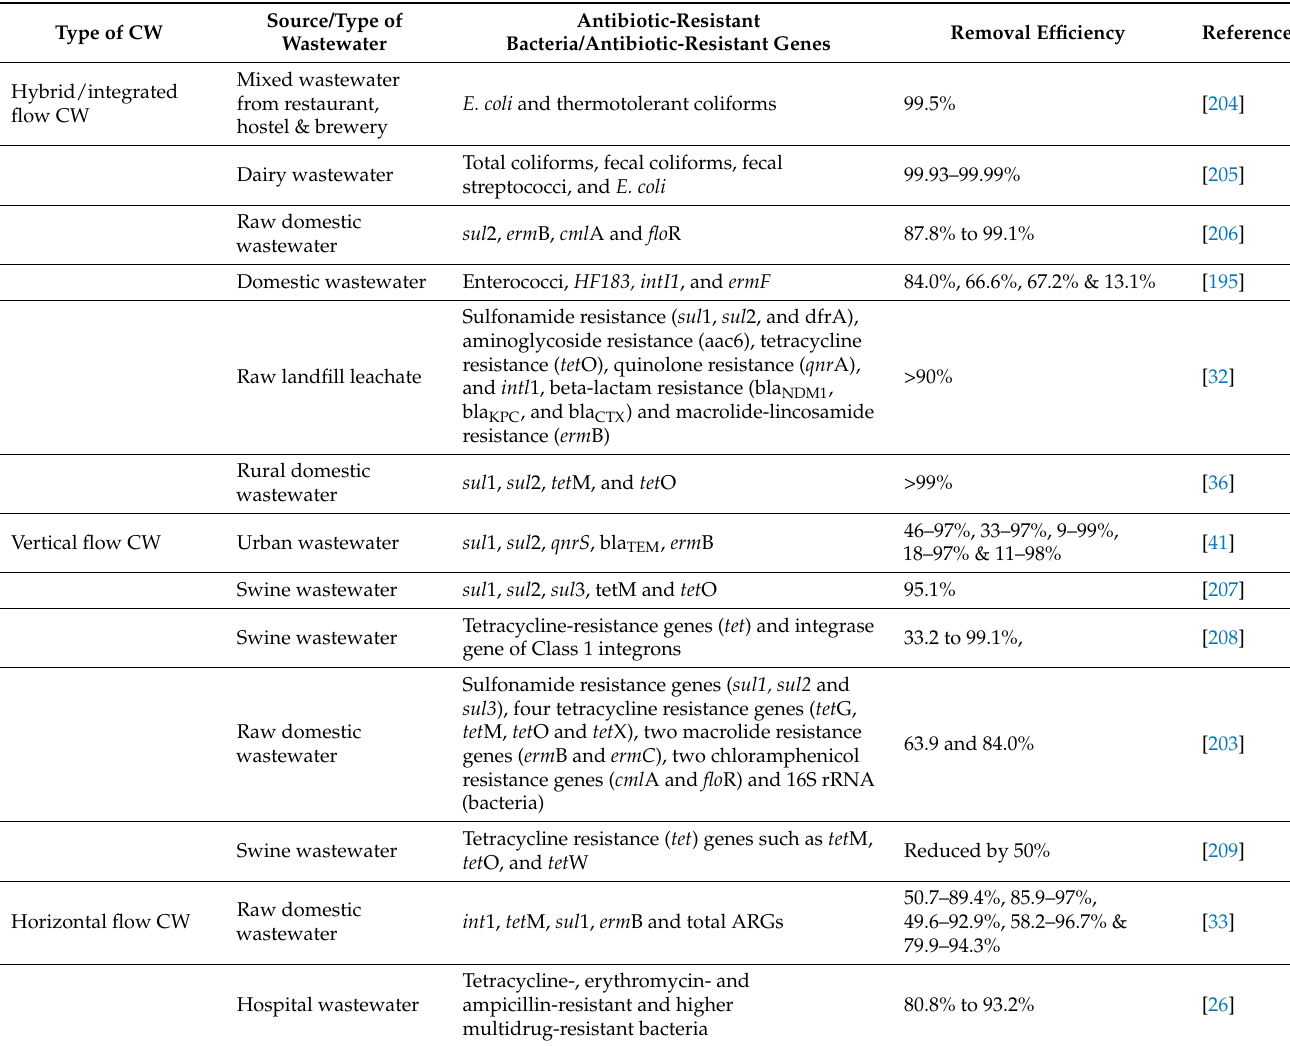
Table 2. Removal efficiency of various CWs for reduction of ARB and resistant